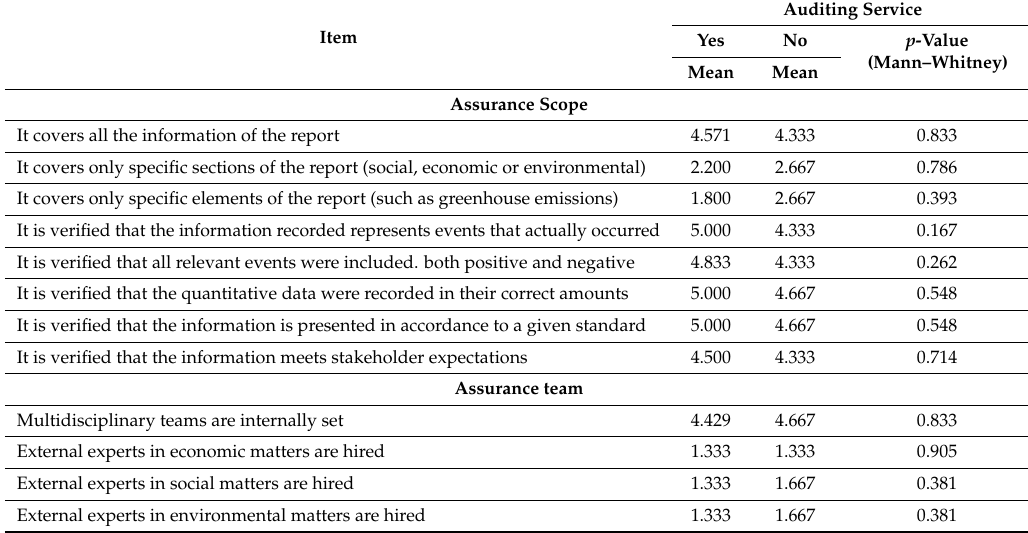
Table 13. Assurance process vs. auditing